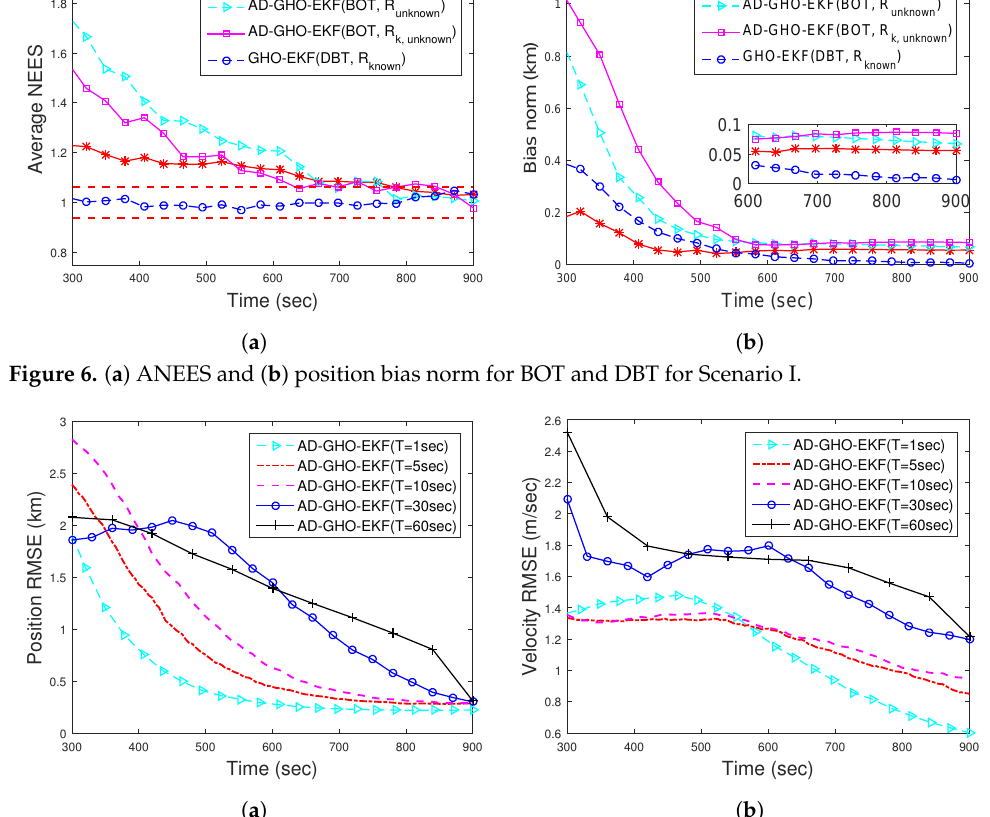
Figure 7. RMSEs of the ( a ) position; ( b ) velocity of the BOT for varying T of R unknown for Scenario I.